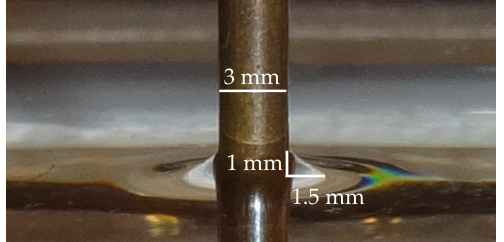
Figure 1. Photo of a meniscus formed around a brass rod exemplifying the boundary between water and the cell center